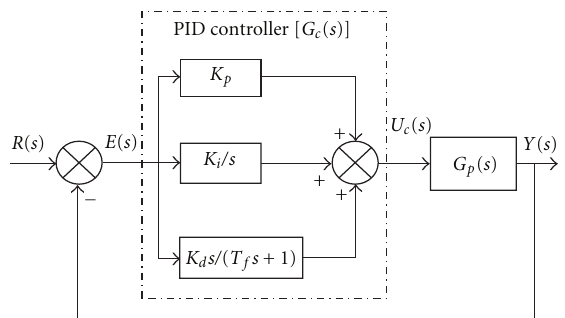
Figure 3: Structure of parallel PID control system.